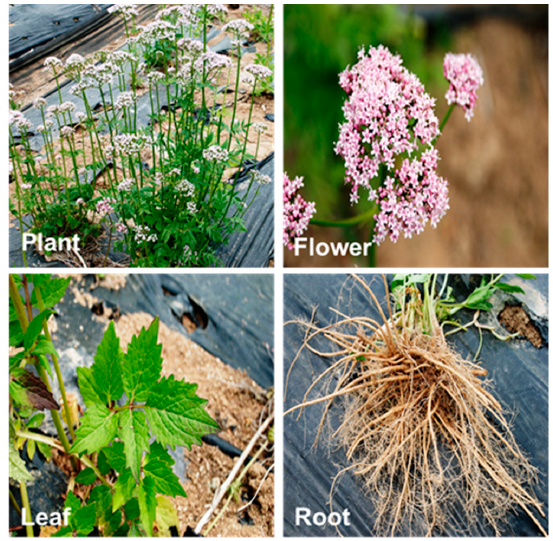
Figure 4. Photographs of two-year-old V. fauriei grown in Pyeongchang, Gangwon-do, South Korea.